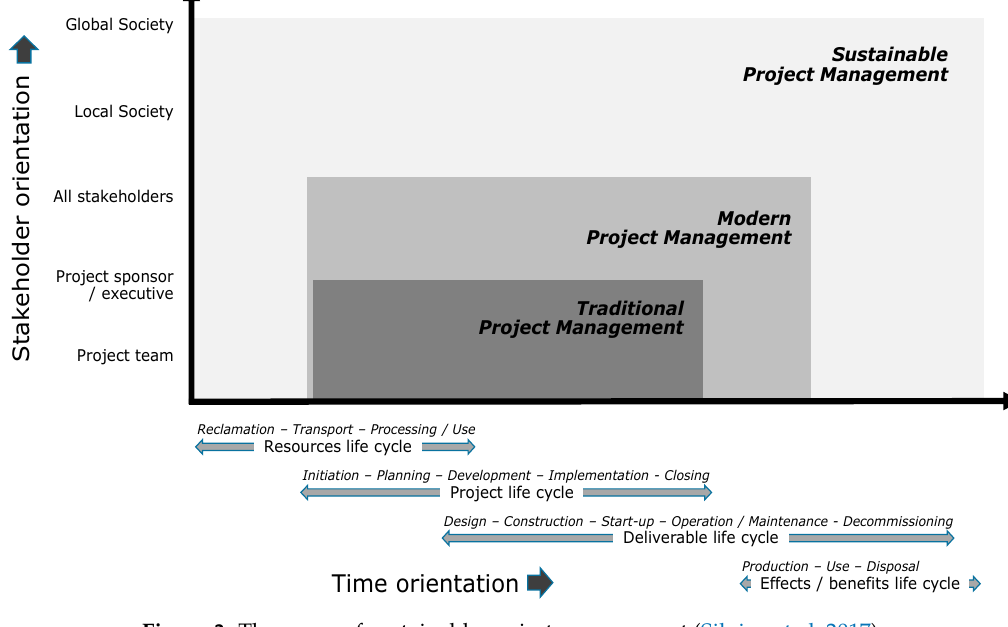
Figure 3. The scope of sustainable project management (Silvius et al. 2017).